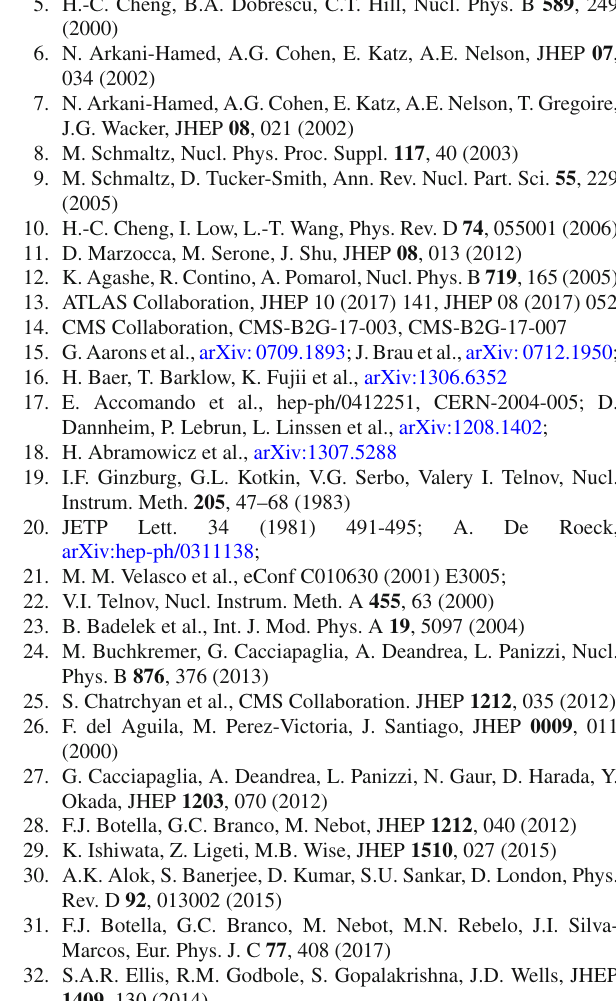
Fig. 4 Excluded regions depending on integrated luminosity at 2 σ (left) and 3 σ (right) level on the g ∗ ∼ m T plane for